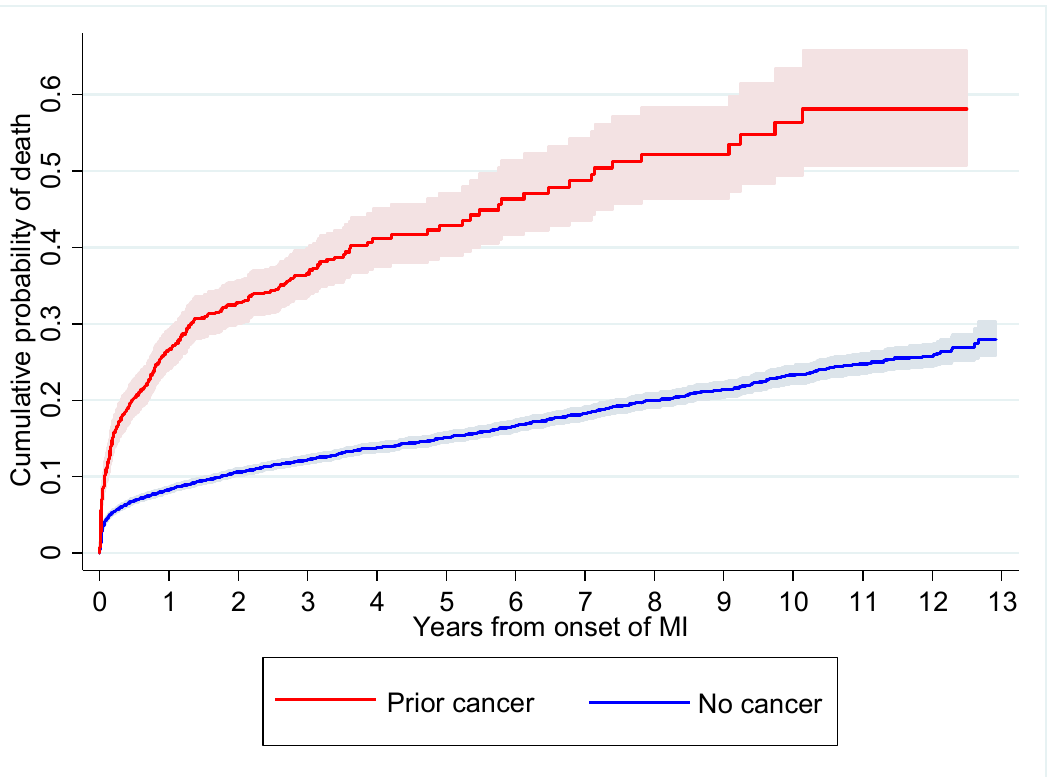
Figure 3. Post-AMI mortality according to cancer status. The red line represents the prior cancer group while the blue line represents the no cancer group. Confidence interval indicated by shaded area surrounding line. AMI: acute myocardial infarction